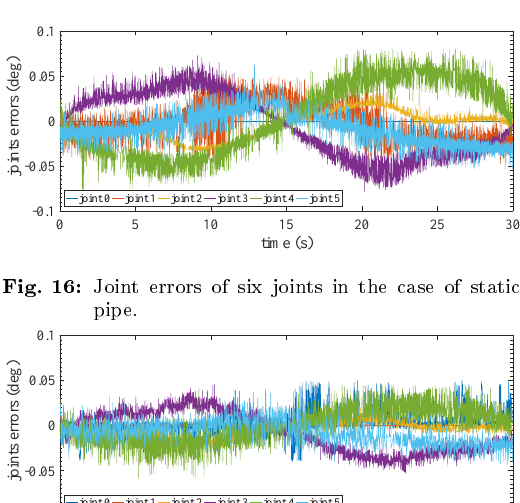
Fig. 17: Joint errors of six joints in the case of rotary